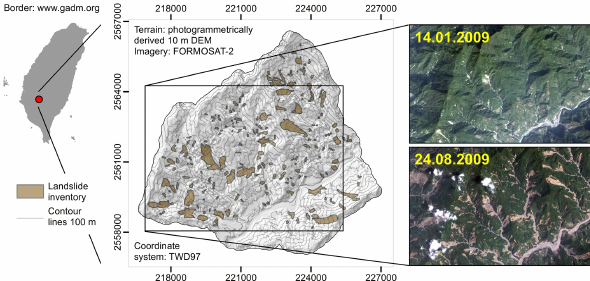
Figure 9. Location, terrain and landslide inventory of the Kao Ping Watershed, Taiwan. Comparison of the satellite images illustrates the landslide-induced land cover changes associated with the Ty- phoon Morakot. The landslide inventory builds on the interpretation of the FORMOSAT-2